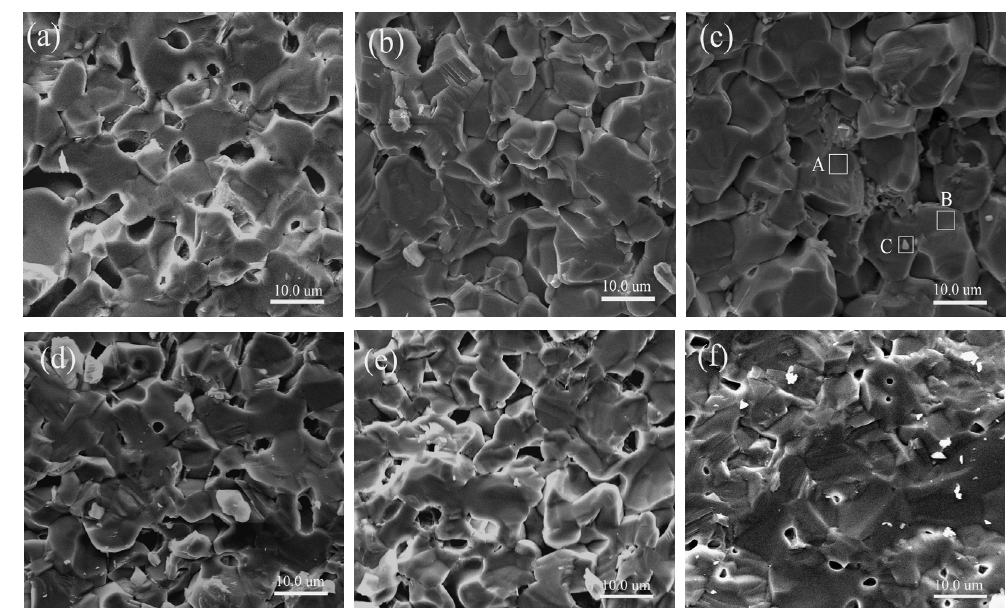
Fig. 4 Typical SEM photographs of polished and thermally etched surfaces for Li 3 Mg 2 Sb 1– x O 6 ceramics under different firing temperatures: (a) Li 3 Mg 2 Sb 0.9 O 6 , 1200 ℃ , (b) Li 3 Mg 2 Sb 0.9 O 6 , 1225 ℃ , (c) Li 3 Mg 2 Sb 0.9 O 6 , 1250 ℃ , (d) Li 3 Mg 2 Sb 0.9 O 6 , 1275 ℃ ,